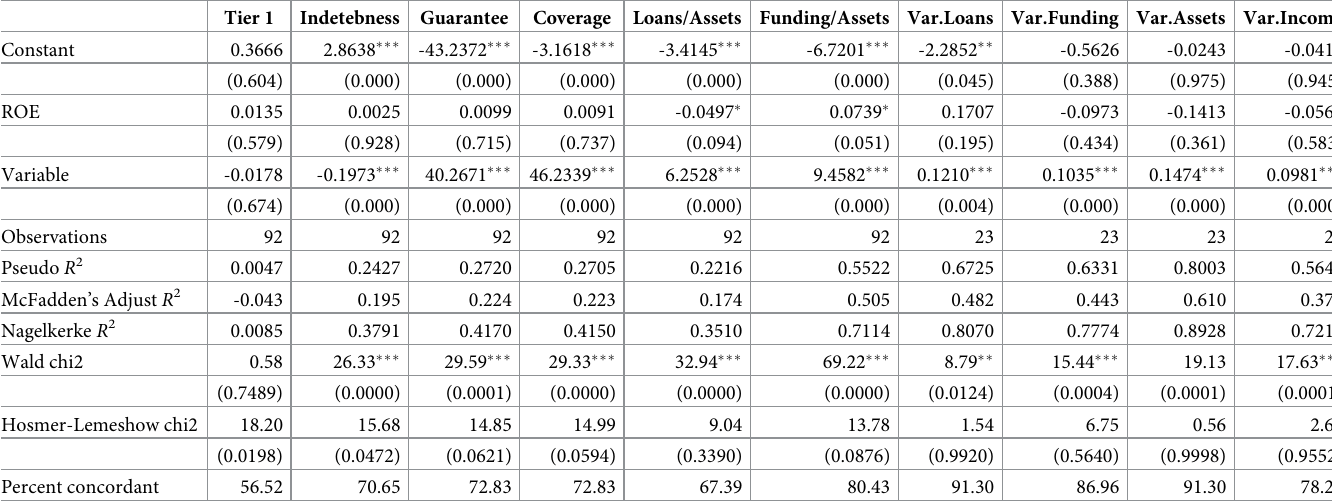
Table 9. Probit regressions between banking model and the individual explanatory